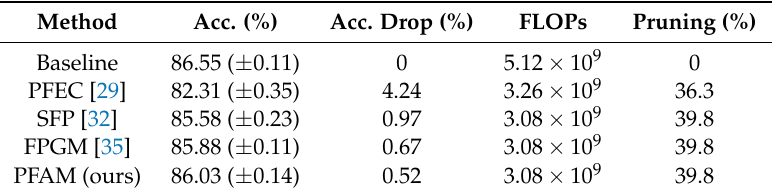
Table 3. Comparison of pruning VGG-16 on the AID